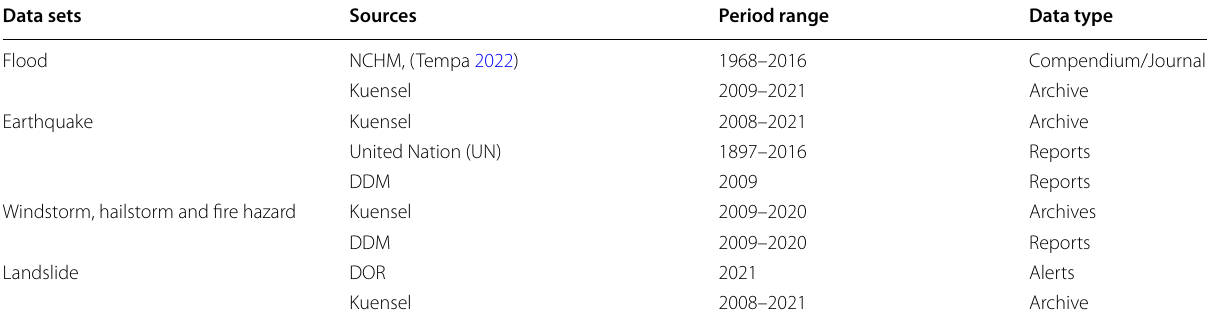
Table 1 Data sets and data source details Data